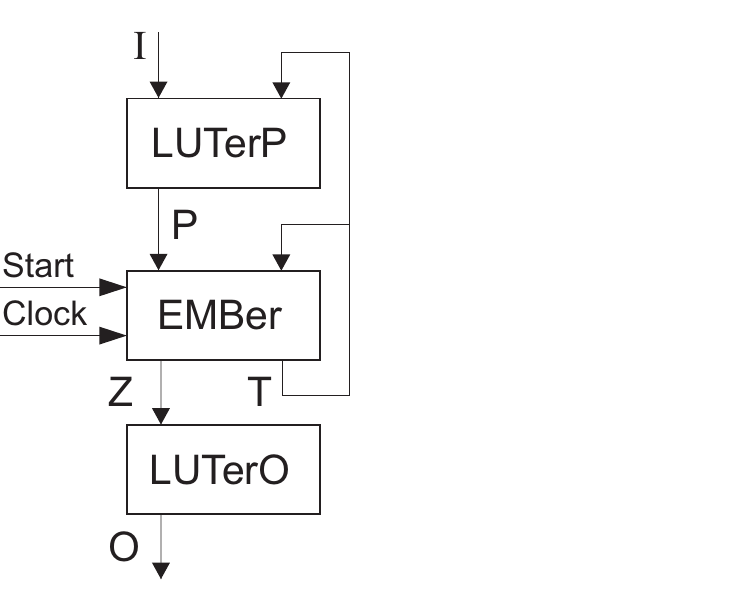
Figure 20. The structural diagram of FPGA-based MPY Mealy